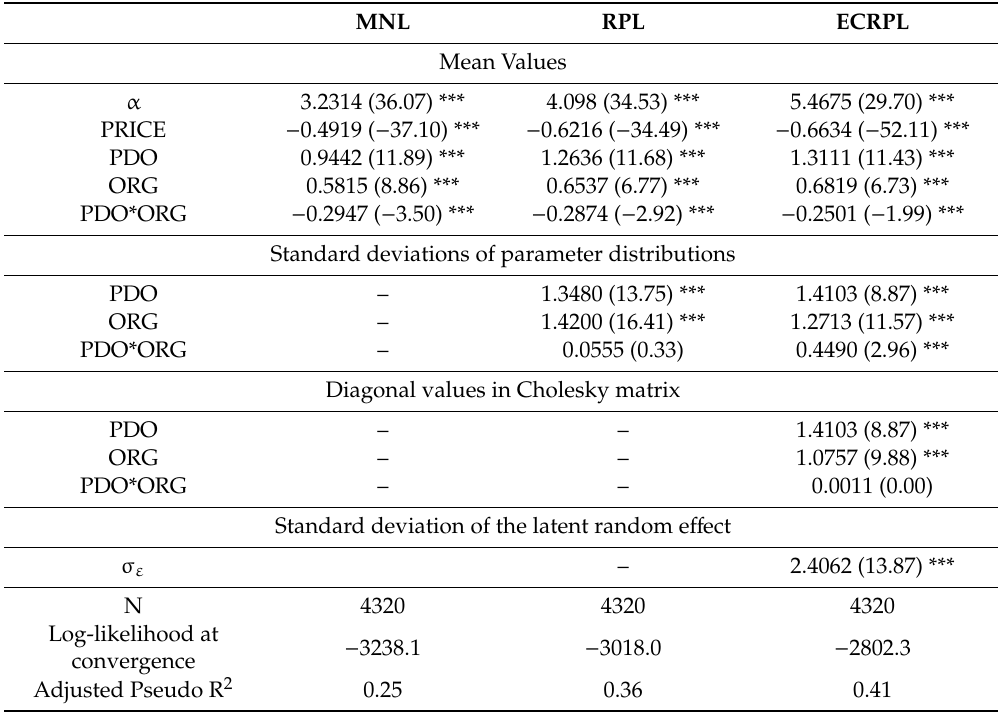
Table 3. Estimates for the utility